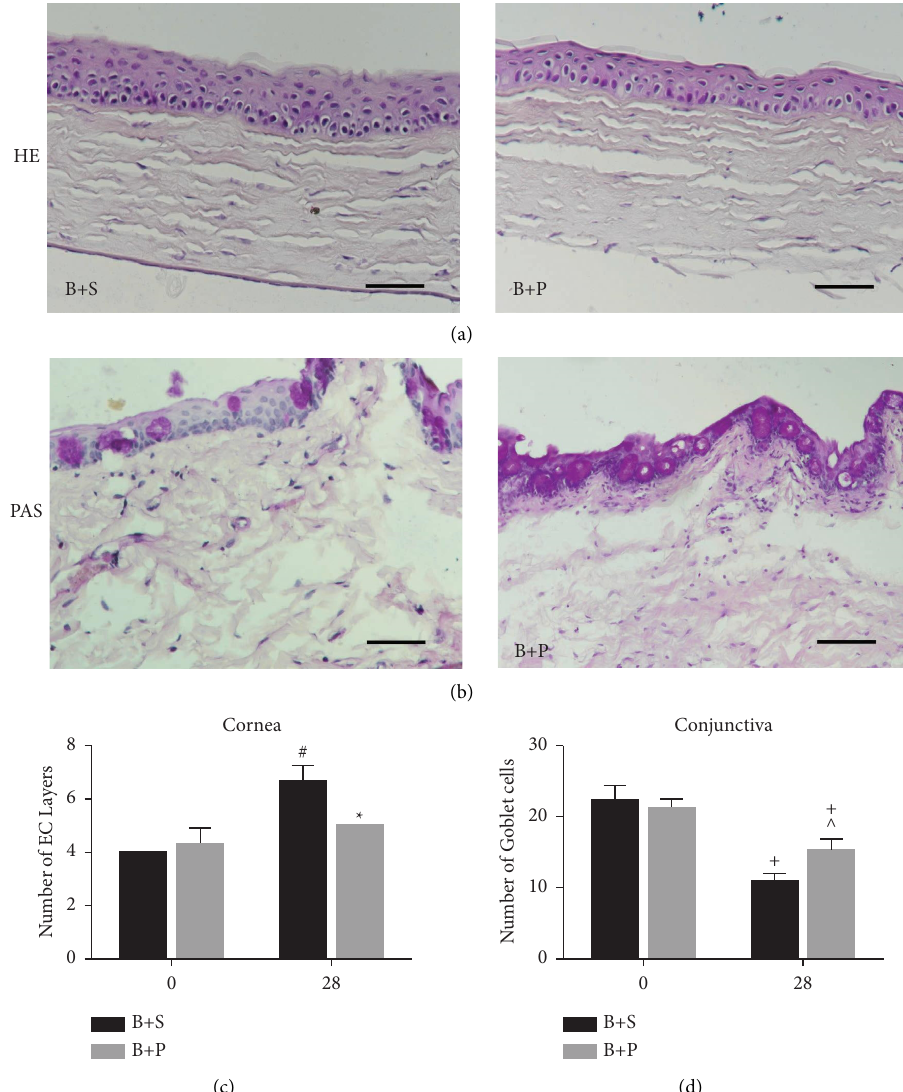
Figure 6: Alterations of corneal structures and goblet cells in the conjunctiva. (a, b) HE staining of corneal epithelium and goblet cells in the conjunctiva observed by PAS staining. Scale bars: 50 μ m . (c) Decreased epithelial corneal layers were recorded after PDTC treatment (B+P vs. B+S: ∗ P < 0 . 01, day 28 vs. day 0: # P < 0 . 05). (d) Number of goblet cells decreased over time (day 28 vs. day 0: + P < 0 . 01). Compared to the B+S group, PAS staining showed markedly increased goblet cells in the B+ P group (B+P vs. B +S: ∧ P < 0 .